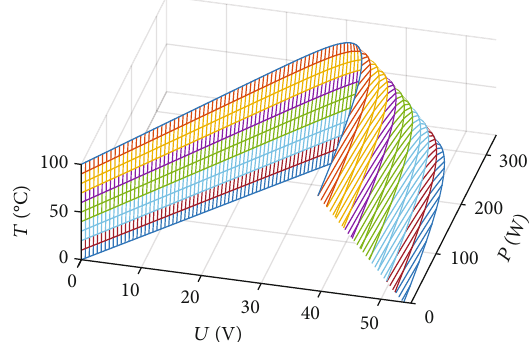
Figure 5: Voltage-power-temperature characteristics.